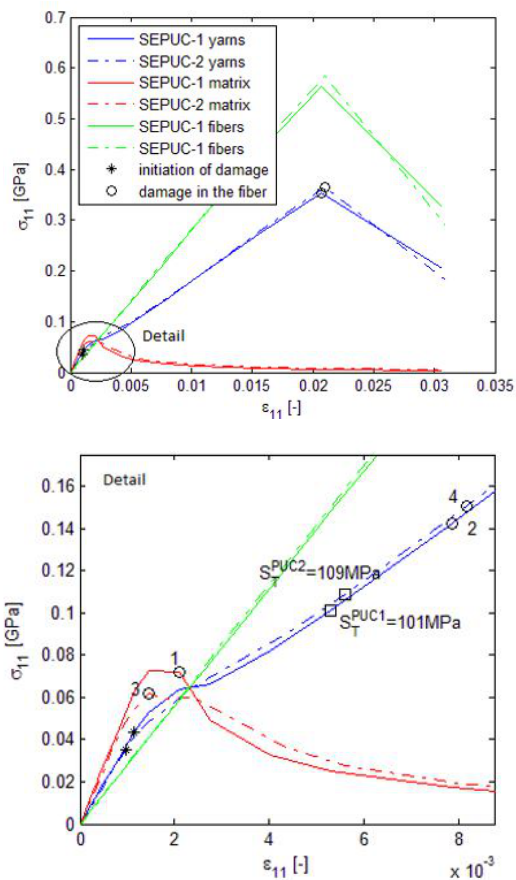
Figure 5. Stress-strain curves under the macroscopic tensile strain in the first transverse